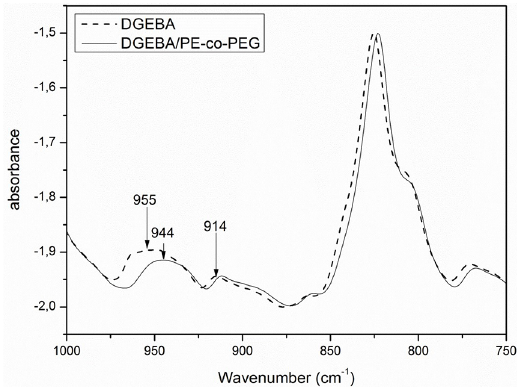
Figure 2. FTIR spectra for epoxy and epoxy/PE-co-PEG blend broadening of the spectrum in the range between 750 cm -1 and 1000 cm -1